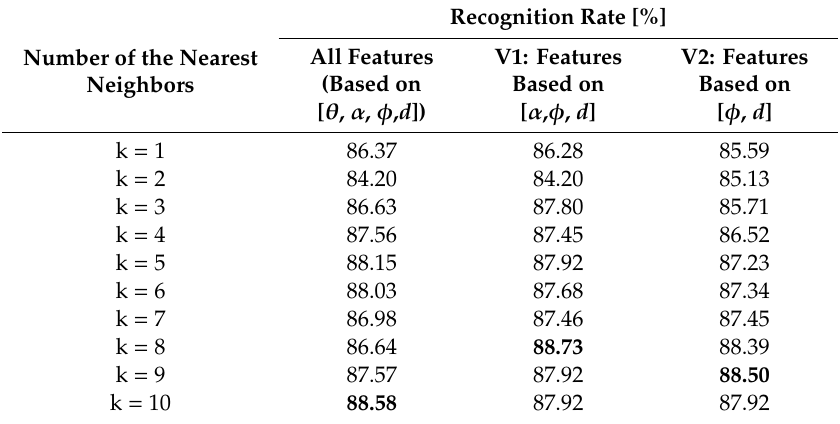
Table 8. Recognition rates for the UTD-MHAD dataset and two variants of feature reduction (eight-fold cross-validation LOSO).